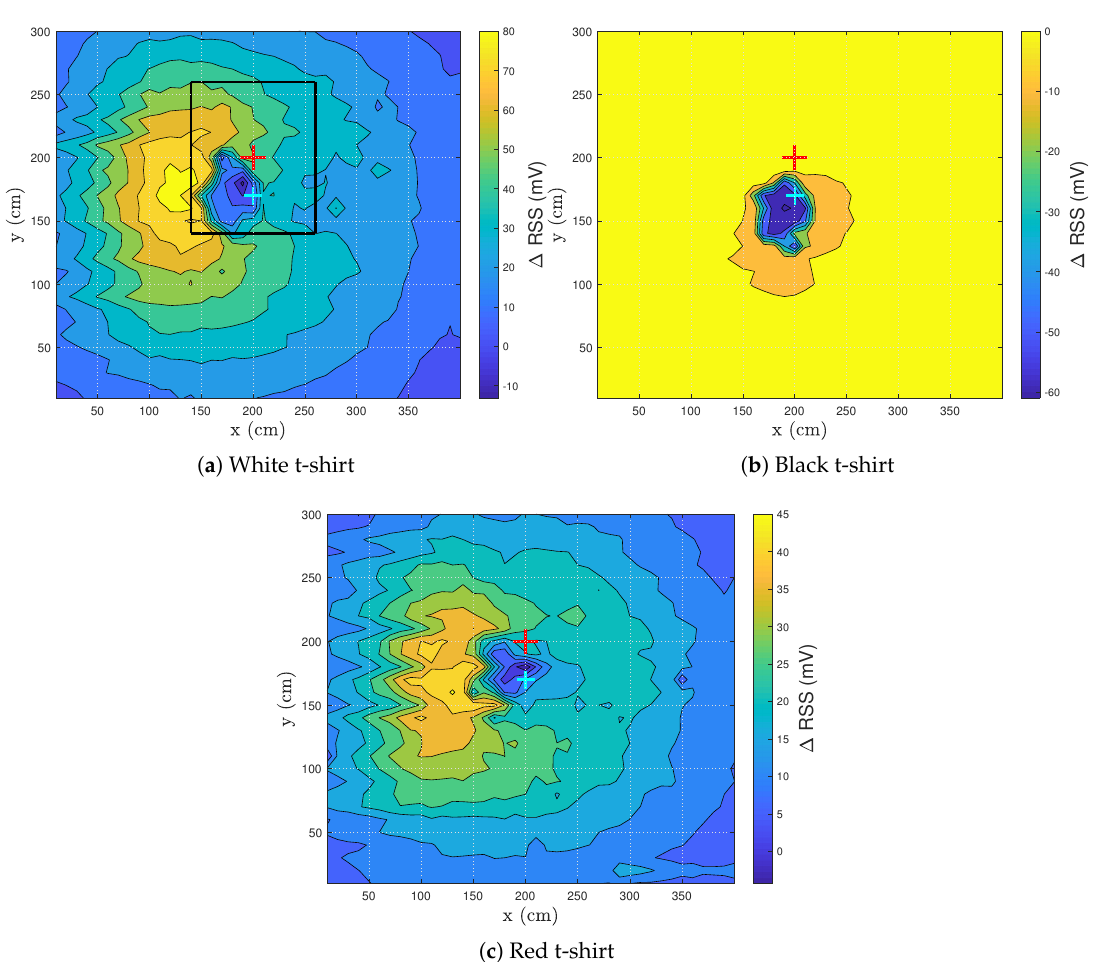
Figure 5. Visualization of the ∆ RSS distribution for the test subject with a room height of 3 m wearing different colored t-shirts. The red cross represents the LED, while the cyan cross denotes the PD. The black square shows the occurrence area of the ∆ RSS